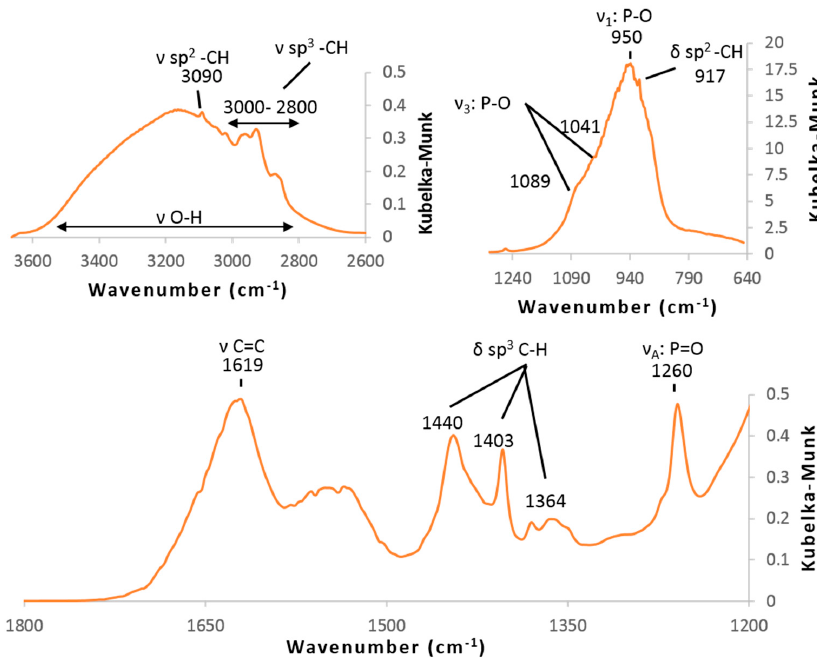
Figure 2. DRIFT spectra of samples (TiO 2 ) 100 (VPA) at 150 ◦